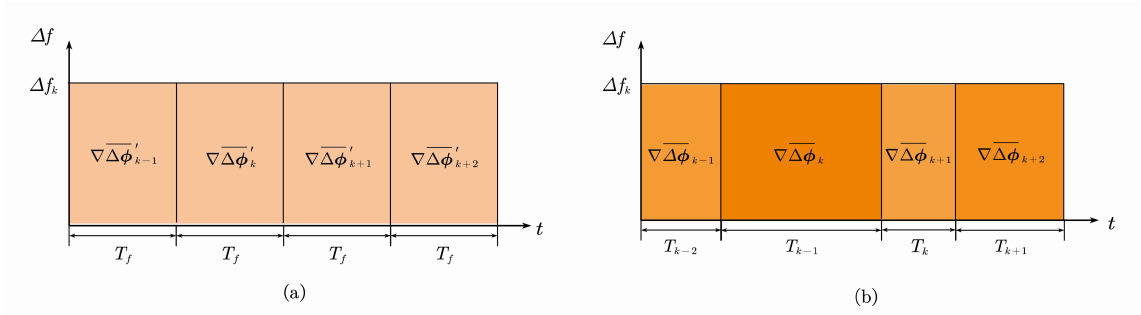
Figure 3. The comparision between ∇ ∆ φ k in tracking continuous CDMA signal and PRPS. ( a ) ∇ ∆ φ (cid:48) k of tracking continuous CDMA signal; ( b ) ∇ ∆ φ k of tracking